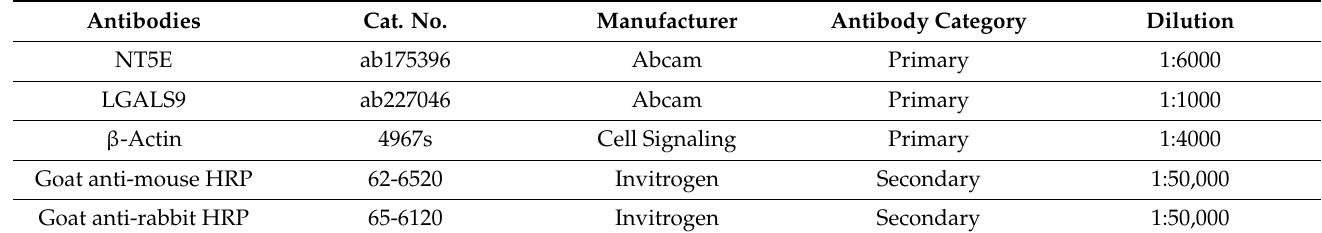
Table 2. List of antibodies.